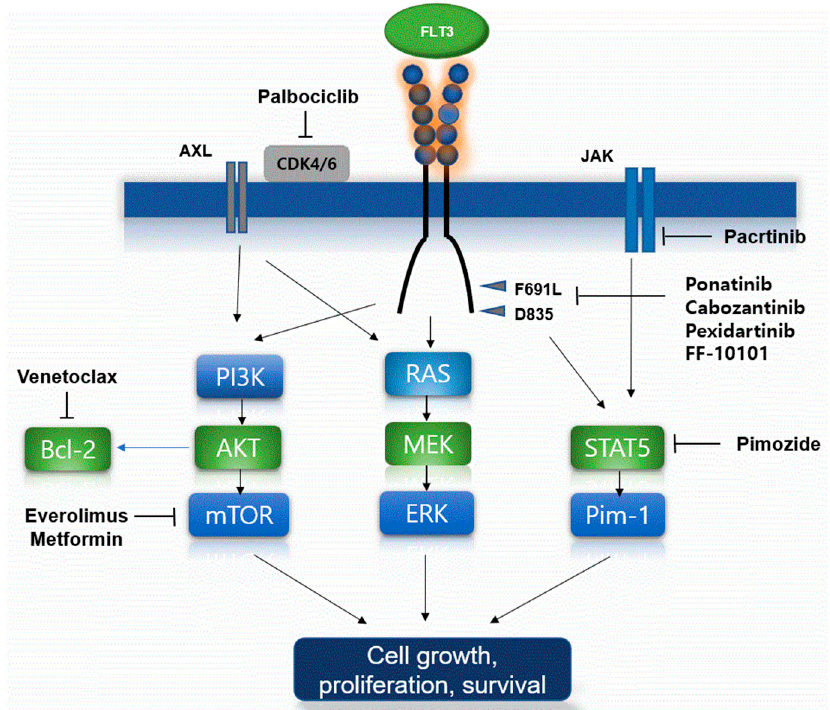
Figure 1. Proposed mechanisms of FLT3 inhibitor resistance and the established overcoming agents. Schematic of FLT3 inhibitor resistance mechanism including several types of FLT3 mutations were present. Several targeted agents such as venetoclax, proteasome inhibitors, multikinase